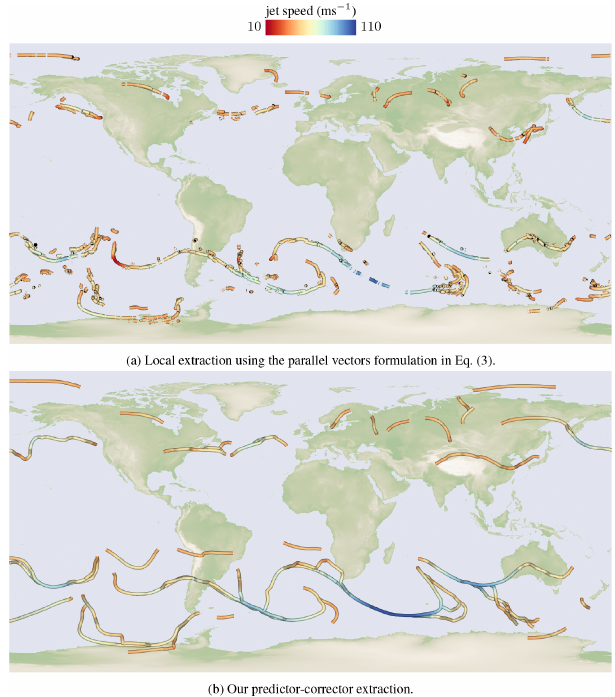
Figure 4. (a) Local extraction methods on unsmoothed data may lead to spurious jet core lines that need substantial post-processing and filtering. (b) Our method results in continuous curves. Extrac- tion results are shown for 1 September 2016 at